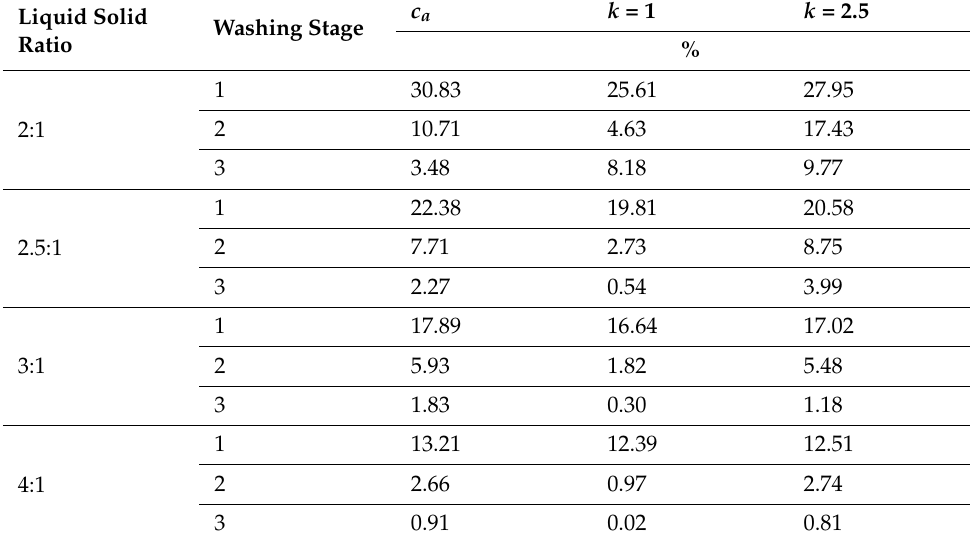
Table 5. The actual and calculated concentrations of the